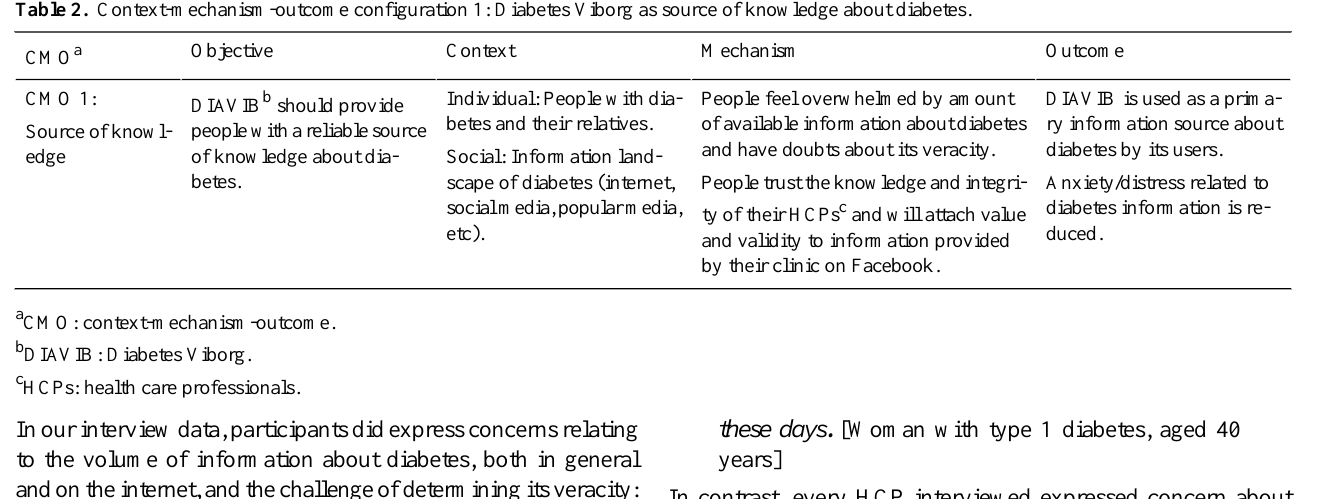
DIAVIB is used as a prima- ry information source about diabetes by its users. Anxiety/distress related to diabetes information is